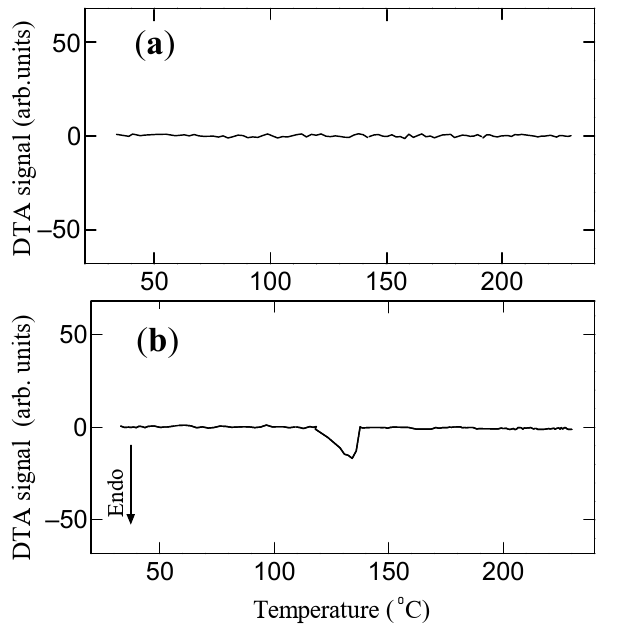
6 of 16 Figure 4. FT-IR spectra in imidazole ( a ), collagen ( b ), and imidazole–collagen composite ( c ). Figure 5a,b show the DTA curves in the collagen and the imidazole–collagen compo- site film of n = 2.0, respectively. We can see that the thermal anomaly cannot be observed in the collagen in the temperature range from 30 °C to 230 °C, as shown in Figure 5a. On the contrary, as shown in Figure 5b, the endothermic peak is observed at around 120 °C with increasing temperature in the imidazole–collagen composite. It is known that the phase transition by melting of imidazole occurs around 90 °C. As shown in Figure 5b, the